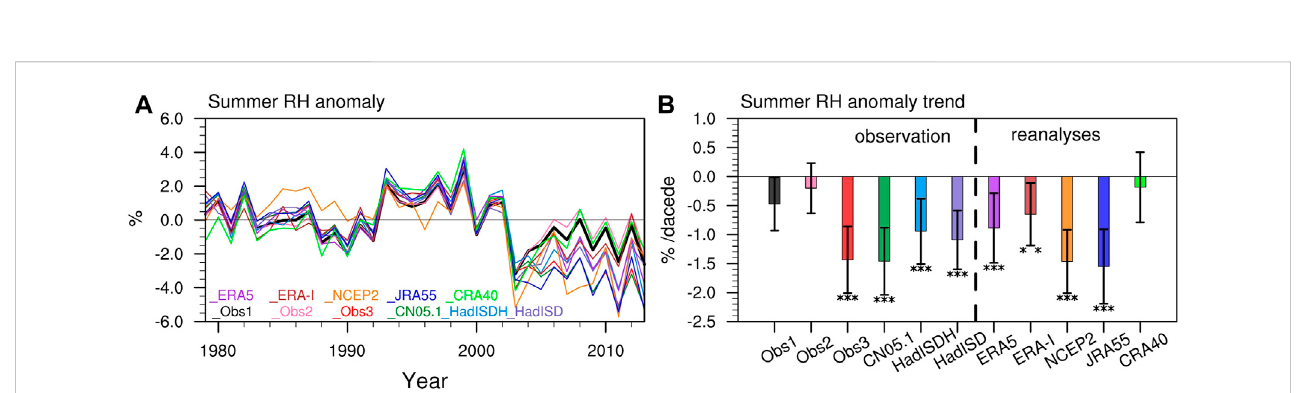
FIGURE 2 Domain-averaged series of RH over southeastern China during 1979 – 2013 based on eleven datasets (A) and their linear trends (B) . The RH series is pre- processing into anomalies with respect to the 1979 – 2008 climatology. The error bars in (B) enclose the 95% con fi dence interval of trend estimates, with symbols “ ** ” and “ *** ” indicating their signi fi cance at the .05 and .01 levels